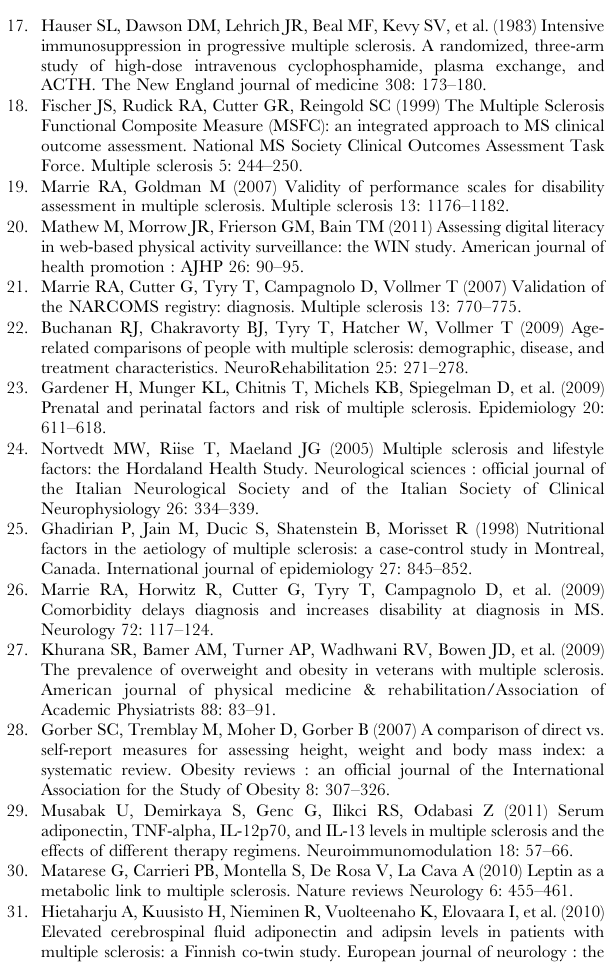
Figure S1 Bland-Altman plot for Patient and Physician Total MSRS scores. Table S1 Illustration: The Multiple Sclerosis Related Severity (MSRS) questionnaire. Table S2 Comparison of patient and disease character- istics for patients treated with glatiramer acetate and interferons.